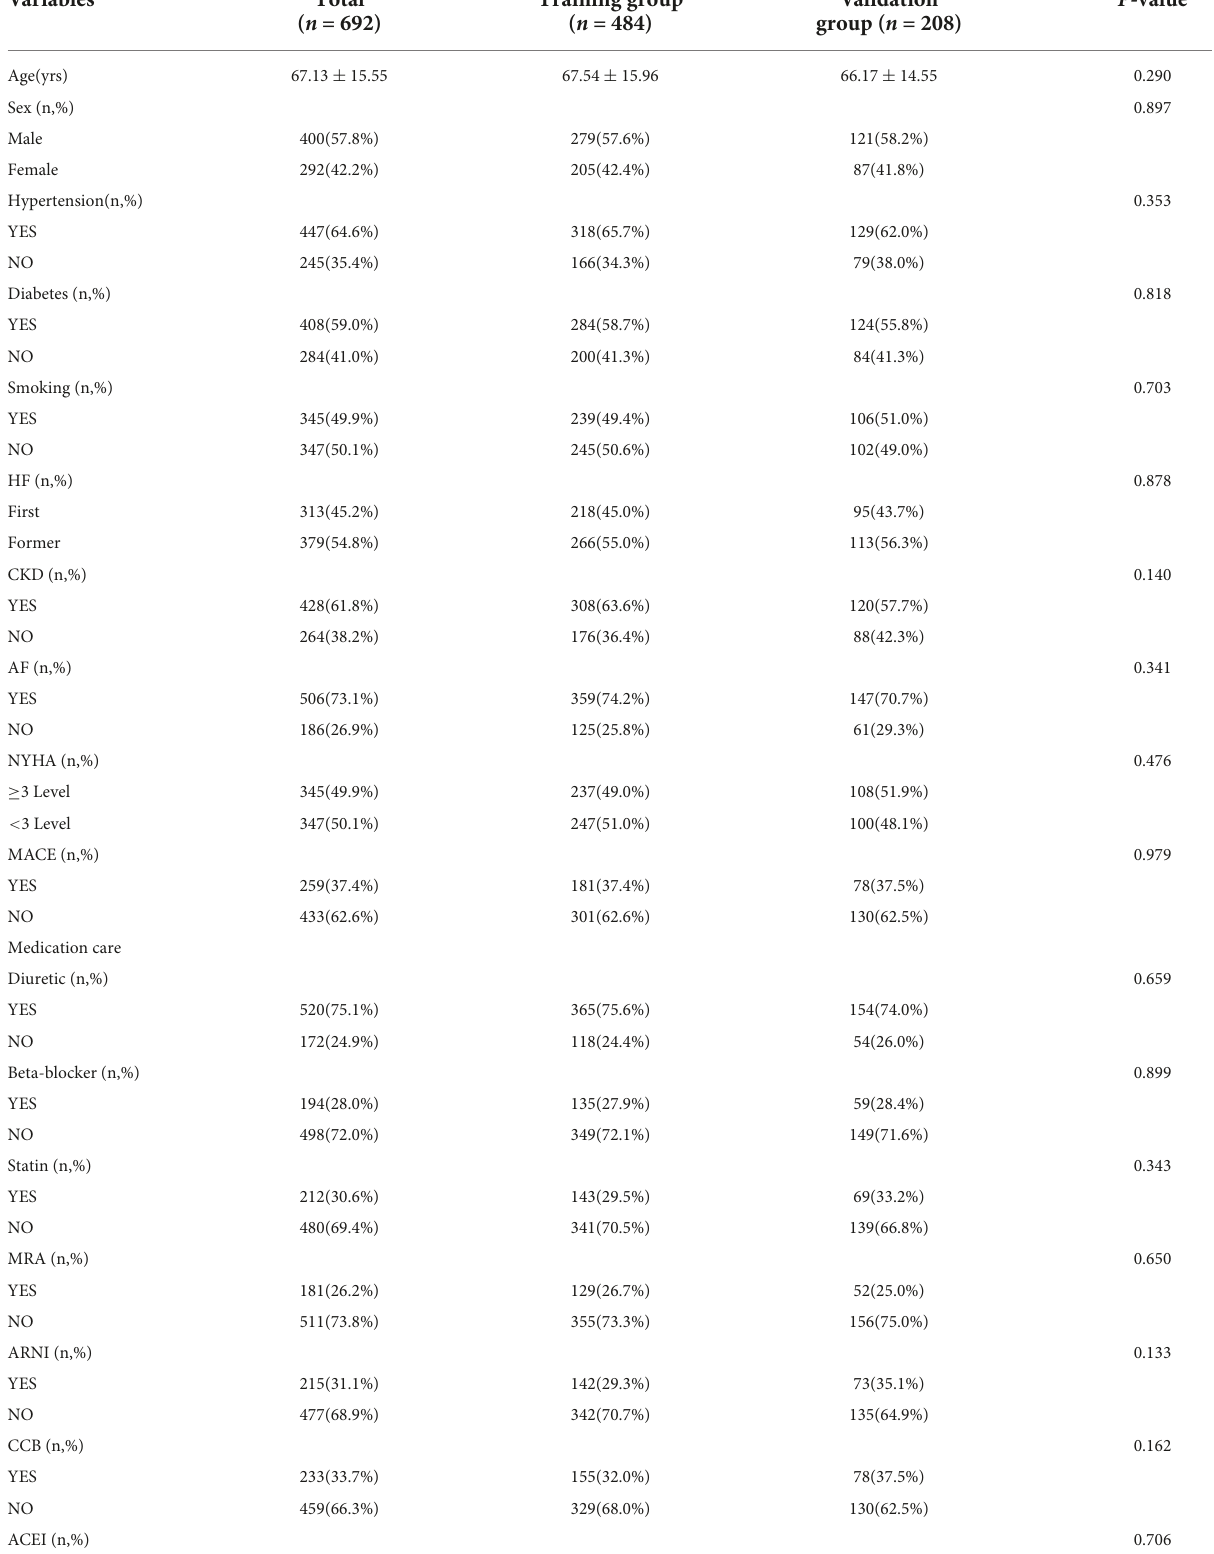
TABLE 1 Baseline characteristics between patients in the training and validation